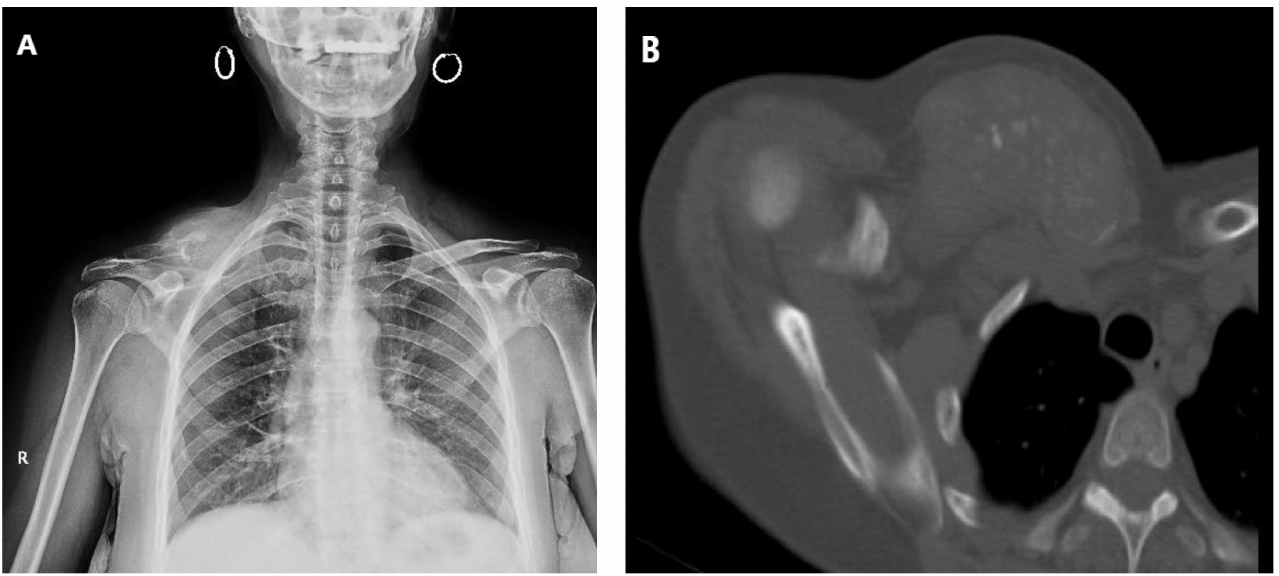
Figure 1. Plain radiograph ( A ) and tomography ( B ) revealing extensive locoregional clavicle metasta- sis in a 60-year-old female, secondary to cervix adenocarcinoma. The patient presented with multiple metastases at diagnosis.